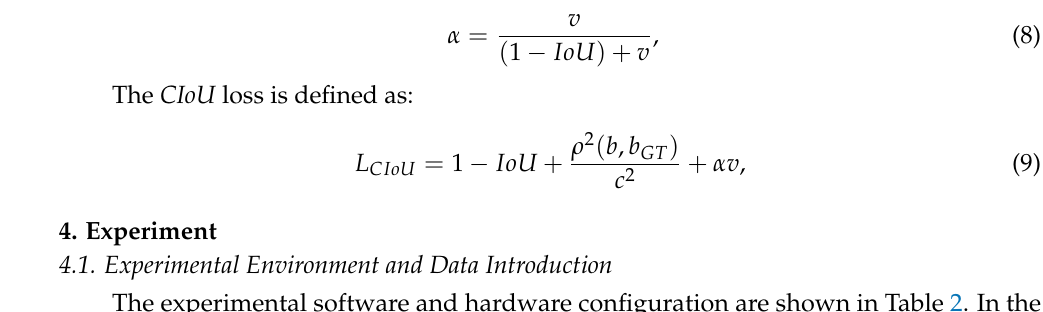
Table 2. Experimental software and hardware configuration.